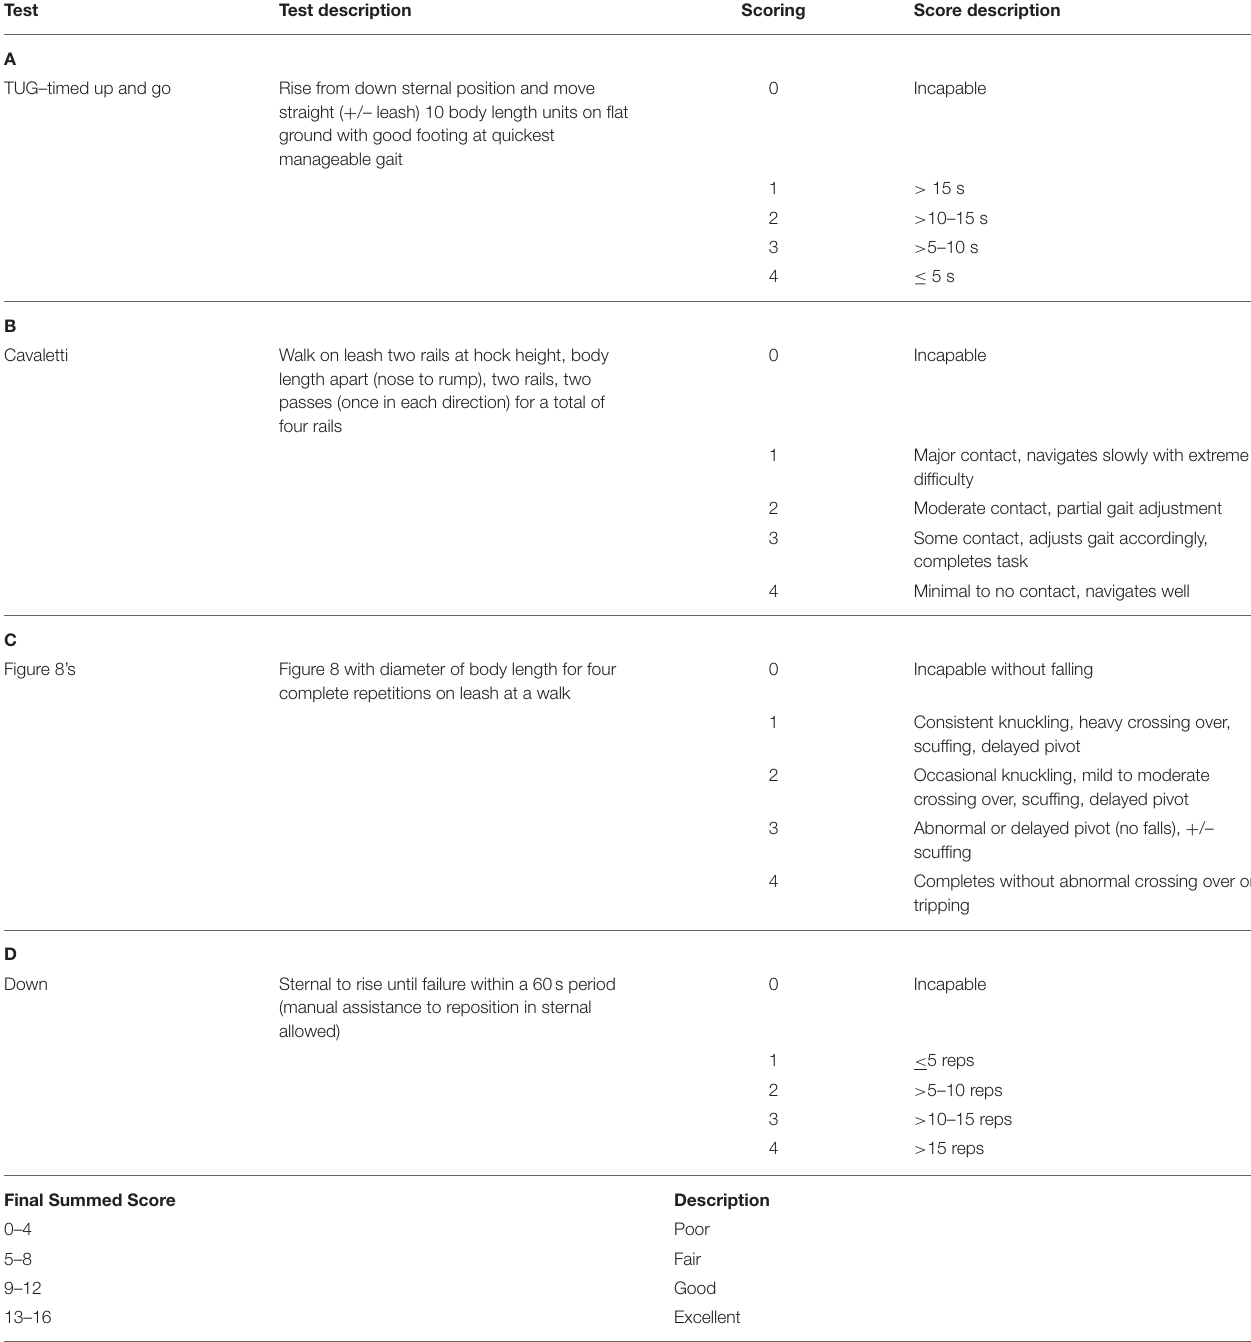
TABLE 4 | Canine geriatric functional score tests in order to be administered to patient.